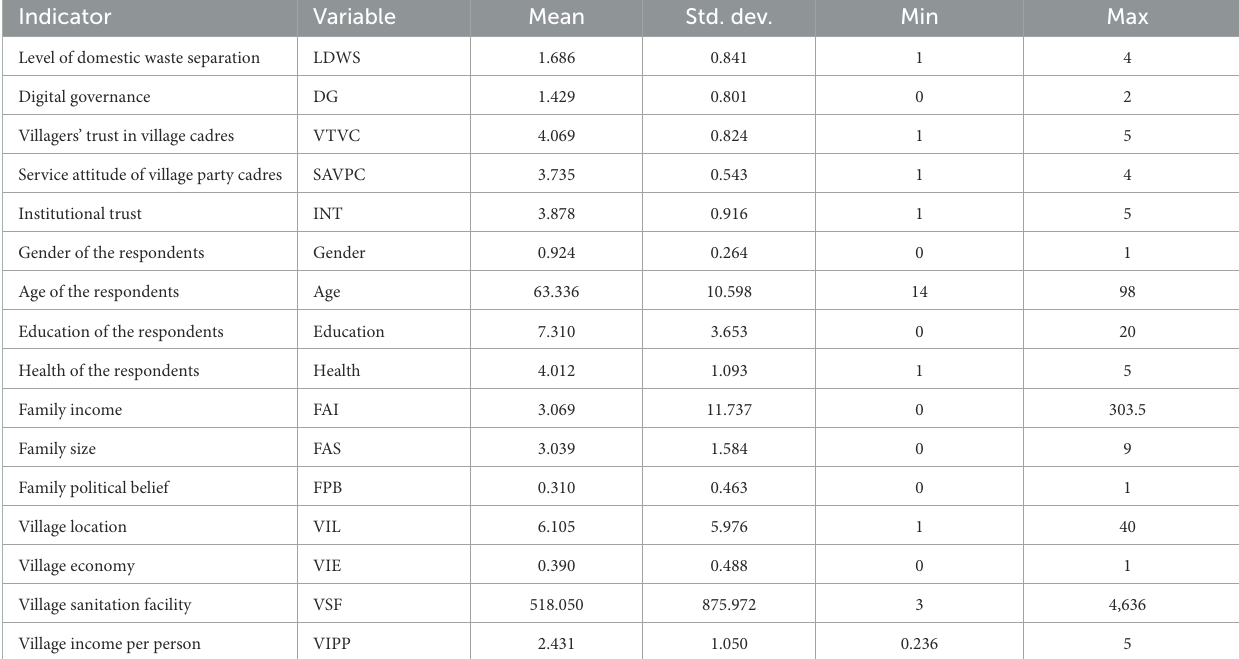
TABLE 2 Variable descriptive